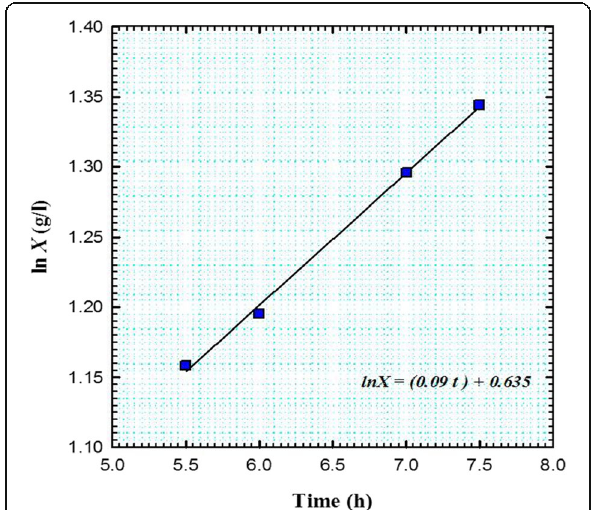
Fig. 11 Yield coefficient for growth of Bacillus subtilis isolate B10 on glucose. X 0 represents the cell mass in the broth at initial time t 0 (g/ l); X , the cell mass concentration in the broth at time t (g/l); S , glucose concentration in the broth at time t (g/l); S 0 , glucose concentration in the broth at initial time t 0